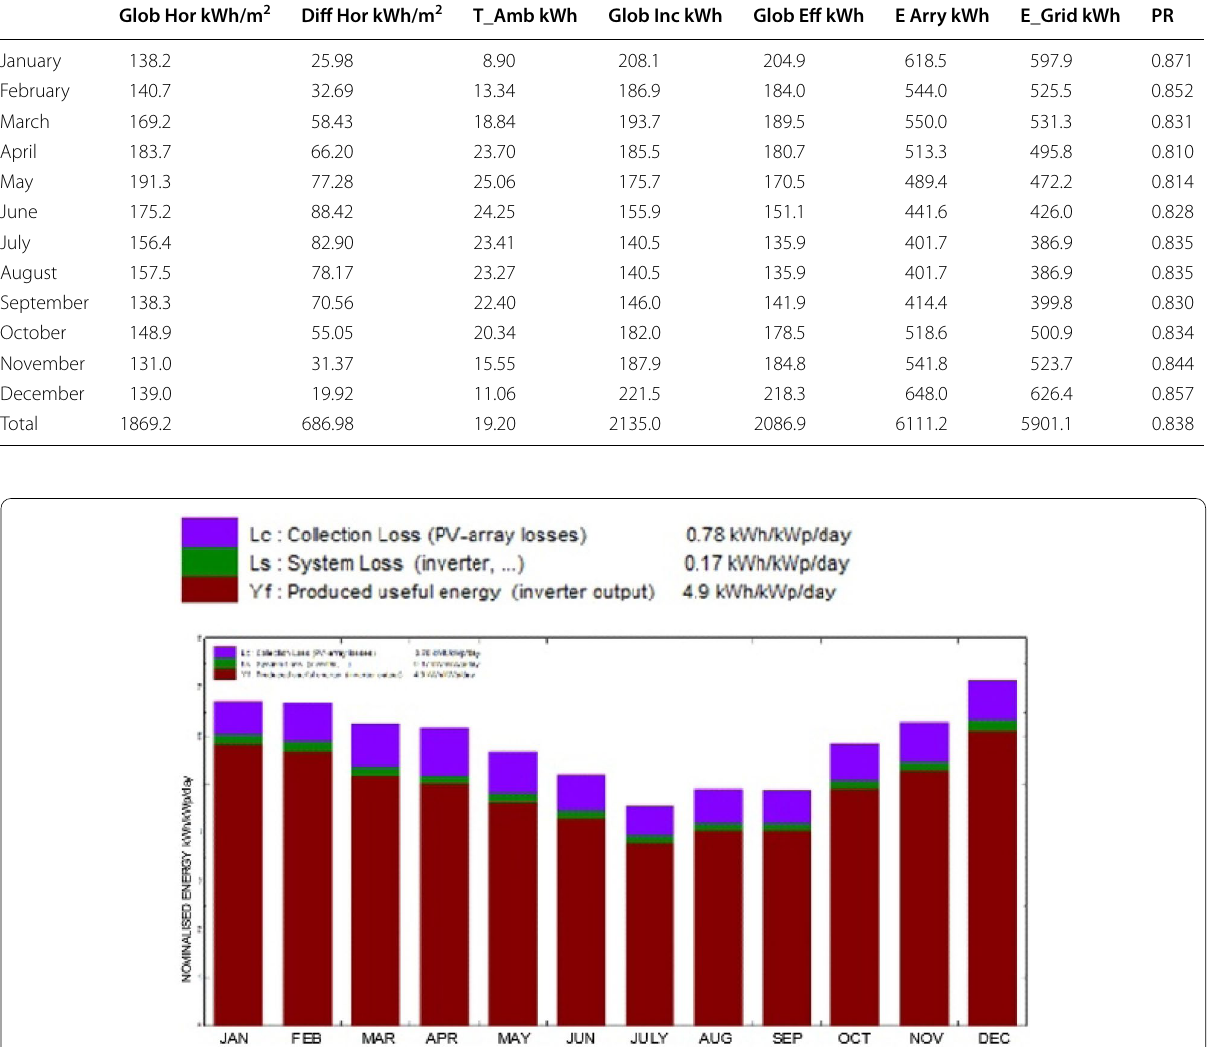
Fig. 10 Normalised energy production per installed kWp of proposed PV